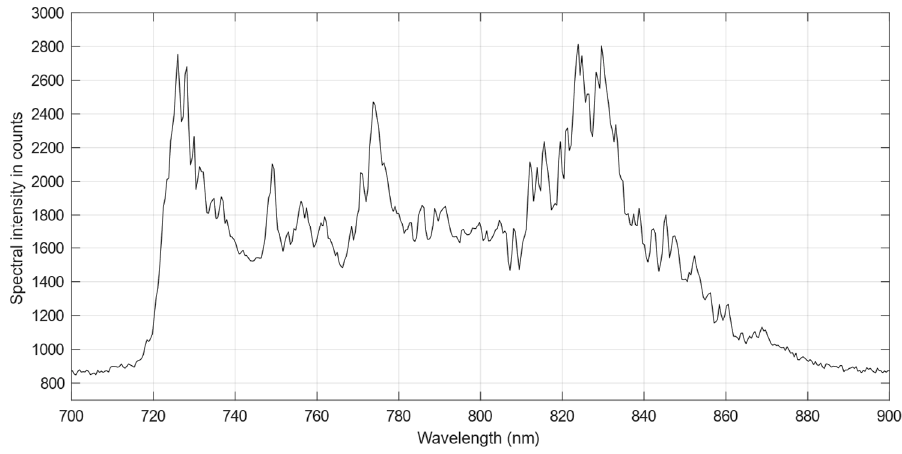
Figure 2. The optical spectrum of one laser. The spectral intensity is measured by a spectrometer (Ocean Optics HR2000+) in counts.